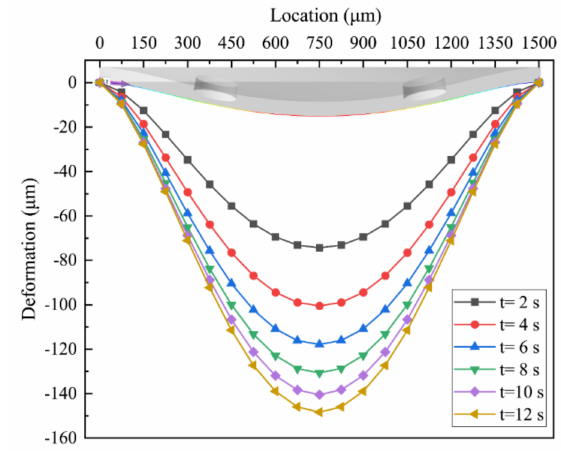
Figure 11. Deformation of the membrane in the path with n = 4 and L = 1000 µ